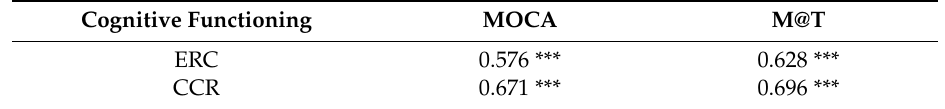
Table 2. Pearson correlations between cognitive reserve (CCR and ERC) and cognitive level (MoCA and